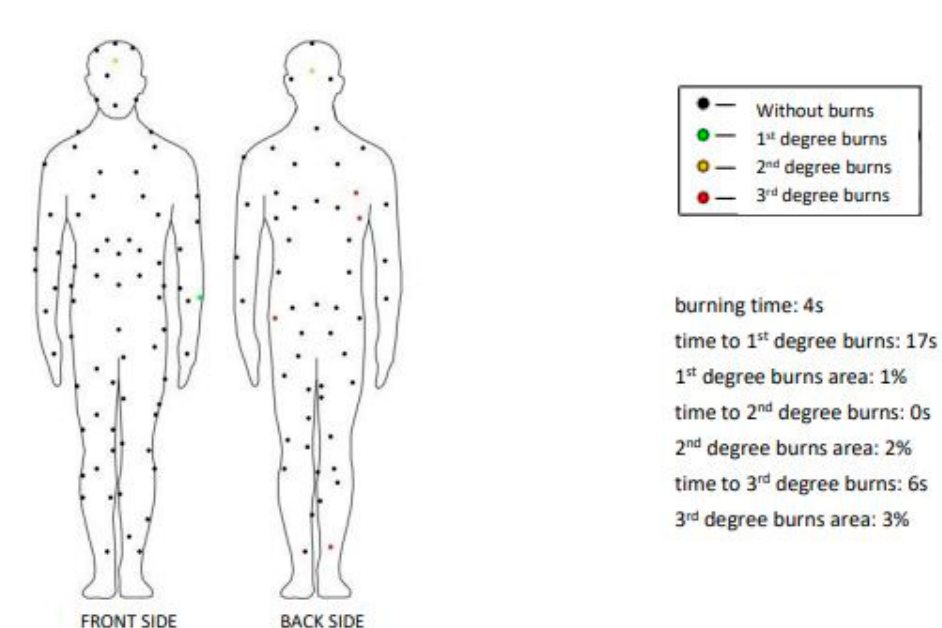
Figure 5. Computer display of the results obtained by the fire manikin test.